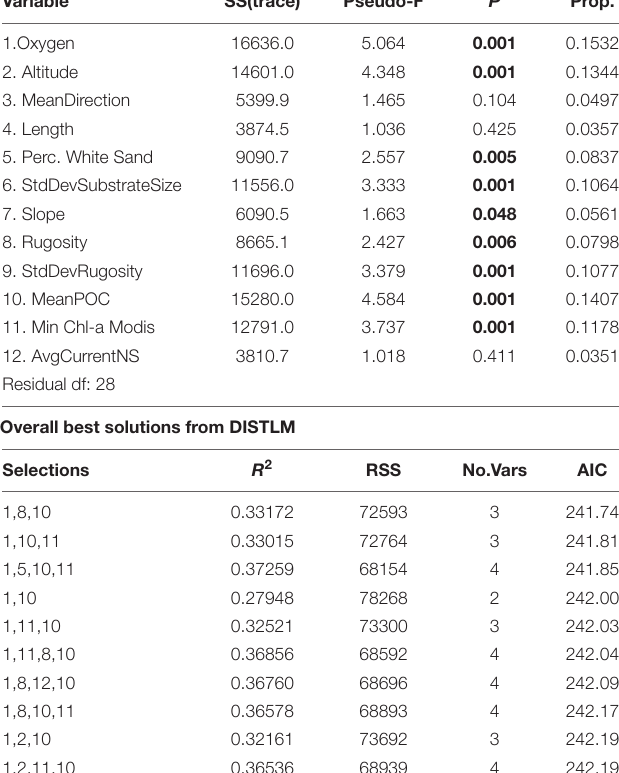
TABLE 1 | DISTLM and dbRDA scores for the North side of